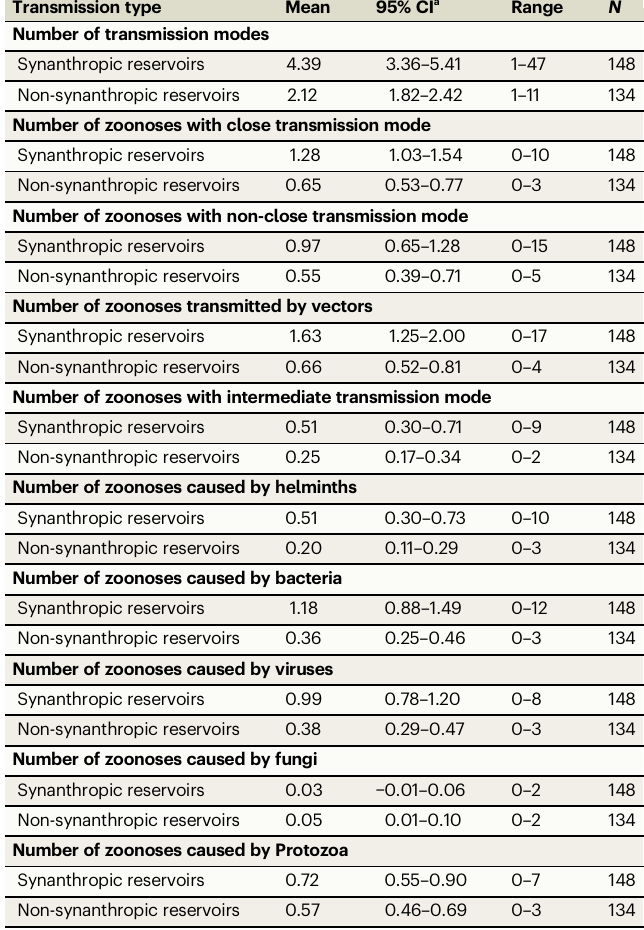
Table 4 | Summary of number of transmission modes, number of zoonoses with different transmission modes, and number of zoonoses caused by different pathogen types in synan- thropic and non-synanthropic rodents